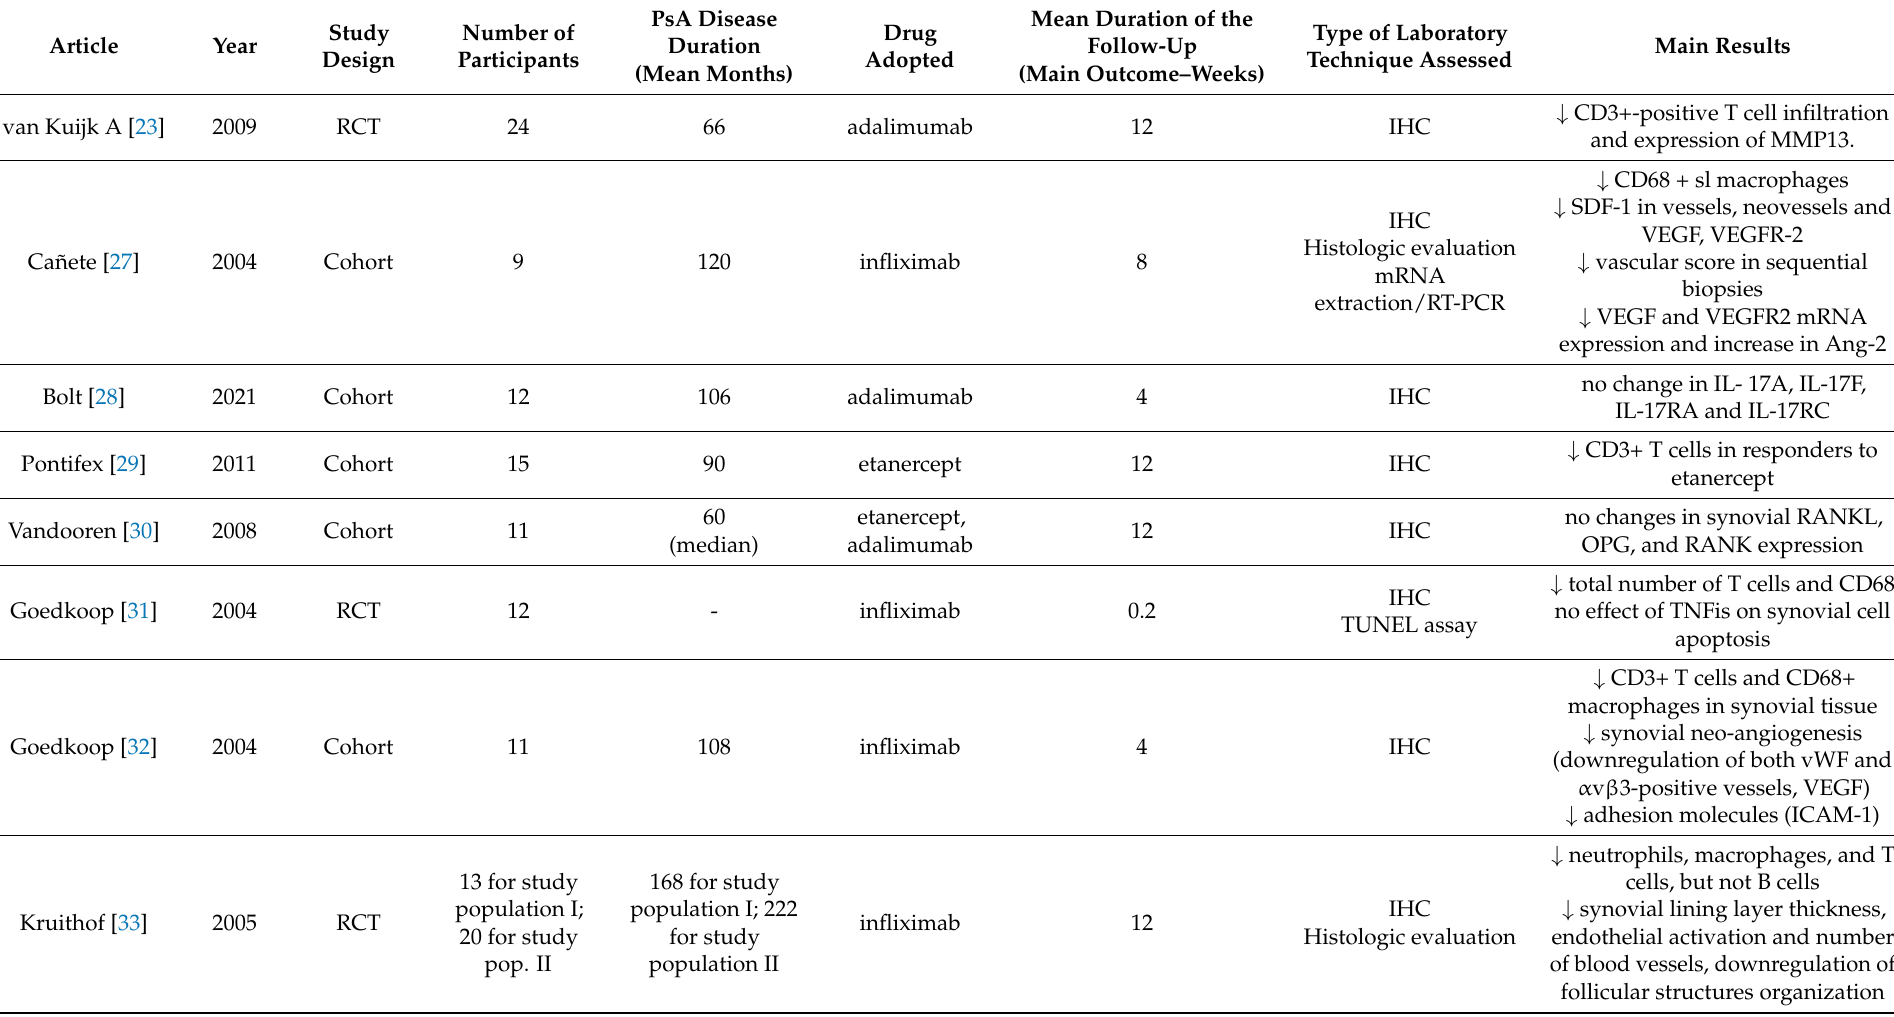
Table 2. Summary of Evidence (longitudinal